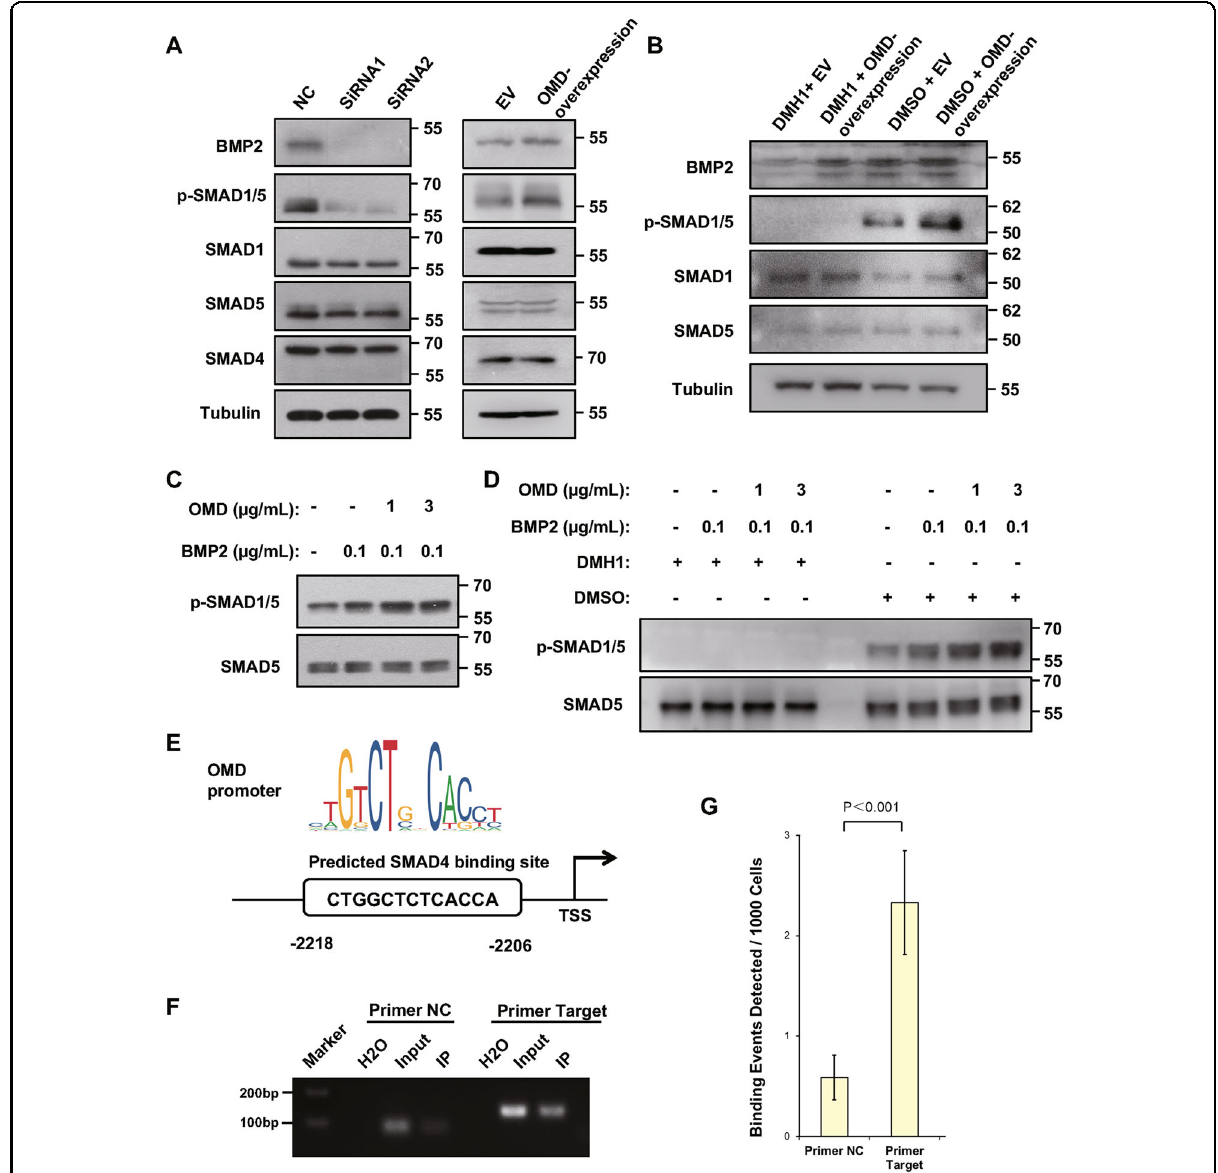
Fig. 4 Effects of OMD on the BMP2-SMAD signaling pathway in hDPSCs. A The levels of BMP2, phosphorylated SMAD1/5, and total SMAD1/4/5 were examined after OMD was silenced or overexpressed. B After treatment with 20 μ M DMH1 to block BMP type I receptor or equal volume DMSO as controls for 24 h, the activation of BMP2/SMAD pathway was checked in hDPSCs overexpressing OMD or empty vector (EV). C hDPSCs were cultured in 5% FBS medium supplied with different concentrations of BMP2 and OMD as shown for 1 h, and then the phosphorylated SMAD1/5 and total SMAD5 were examined. D hDPSCs were cultured in 5% FBS medium supplied with designated concentrations of BMP2 and OMD as well as 20 μ M DMH1 or equal volume DMSO for 1 h. The protein levels of phosphorylated SMAD1/5 and total SMAD5 were examined in hDPSCs via immunoblots. E Schematic of the signi fi cantly enriched motif in SMAD4 binding region predicted by FIMO and JASPAR program. F ChIP